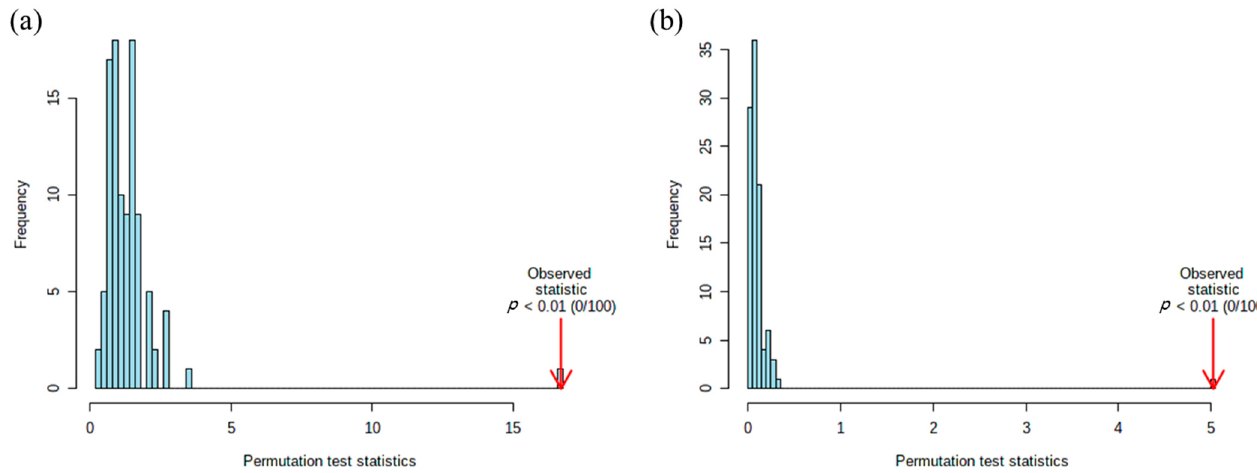
Figure 2. Permutation test to validate partial least squares discriminant analysis score. Permutation numbers were set to 100. X-axis showed the permuted class labels and Y-axis shows optimal number of components by cross validation in ( a ) male groups and ( b ) female groups. Table 1. Differentially regulated metabolites in patients with pattern baldness and normal controls in male groups. Metabolites